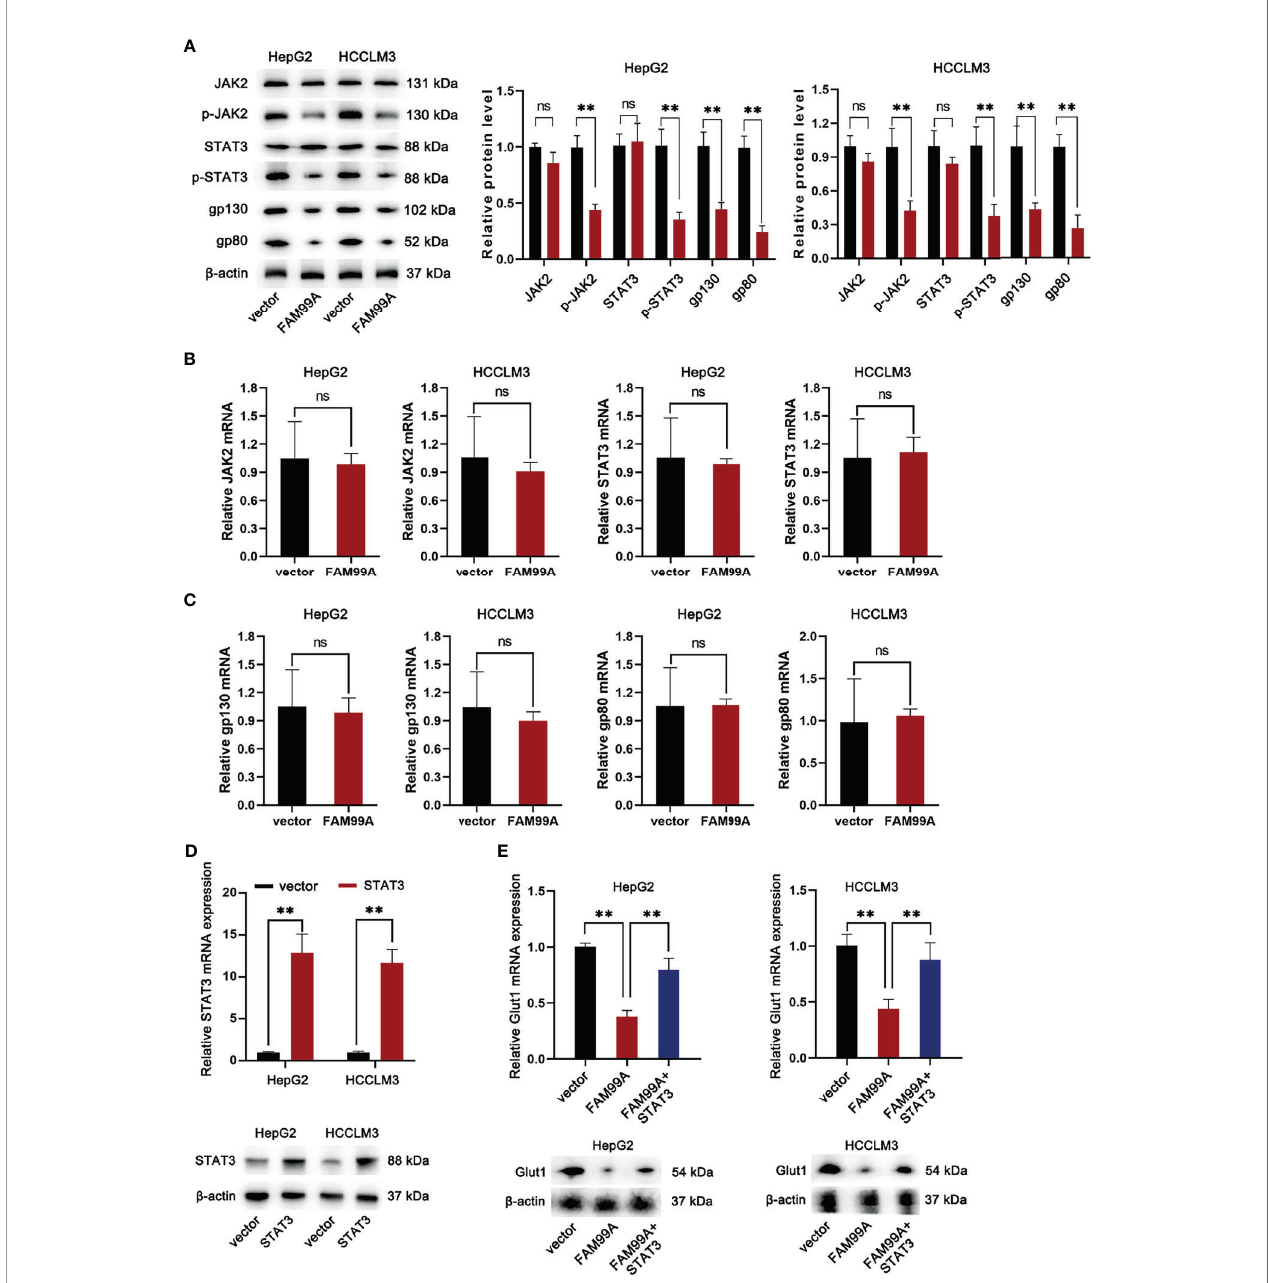
FIGURE 4 | FAM99A moderated the Warburg effect through the JAK2/STAT3 pathway. (A – C) The mRNA expression of JAK2 and STAT3, gp130, and gp80, and protein level of JAK2/p-JAK2, STAT3/p-STAT3, gp130, and gp80 in HCC cells were detected after the overexpression of FAM99A. (D) The mRNA expression and protein level of STAT3 in HCC cells were detected by qRT-PCR and Western blotting assays. (E) GLUT1 expression was detected by qRT-PCR and Western blotting assays after the HCC cells were transfected with vector pcDNA3.1/fam99a or pcDNA3.1/FAM99A+pcDNA3.1/STAT3. ** p < 0.01, ns, no signi fi